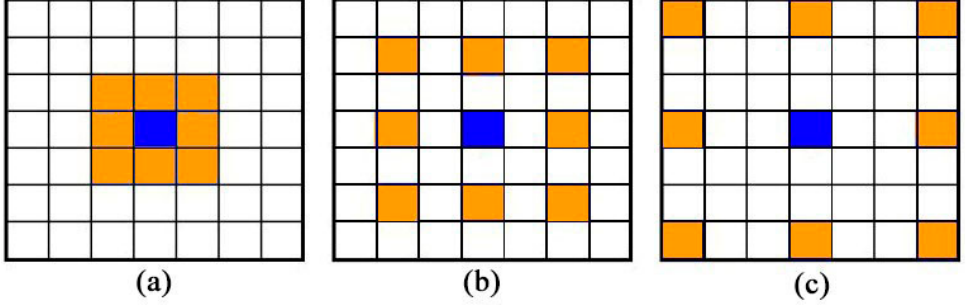
Figure 3. Dilated convolution kernels with different rates. (a), (b), (c) are dilated convolution kernels with dilation rate 0, 1, 2,